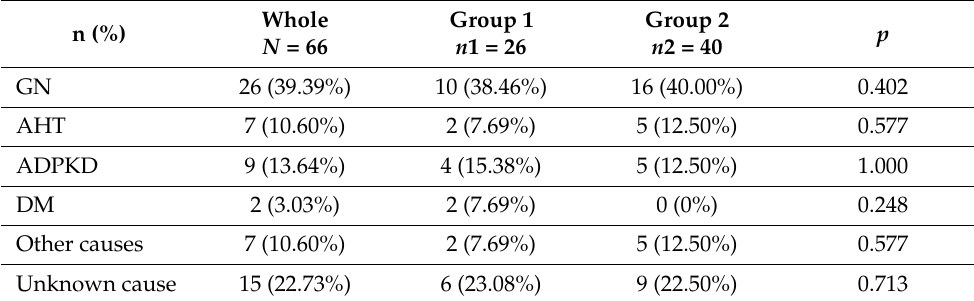
Table 5. Cause of chronic kidney disease of recipients qualified for KTx.